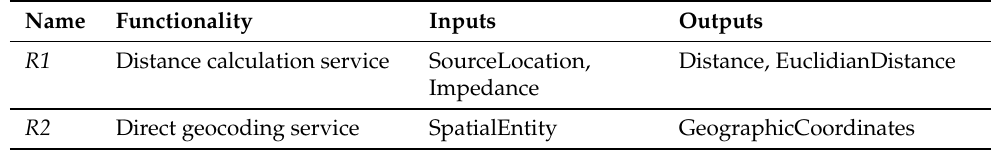
Table 4. Requests R1 and R2